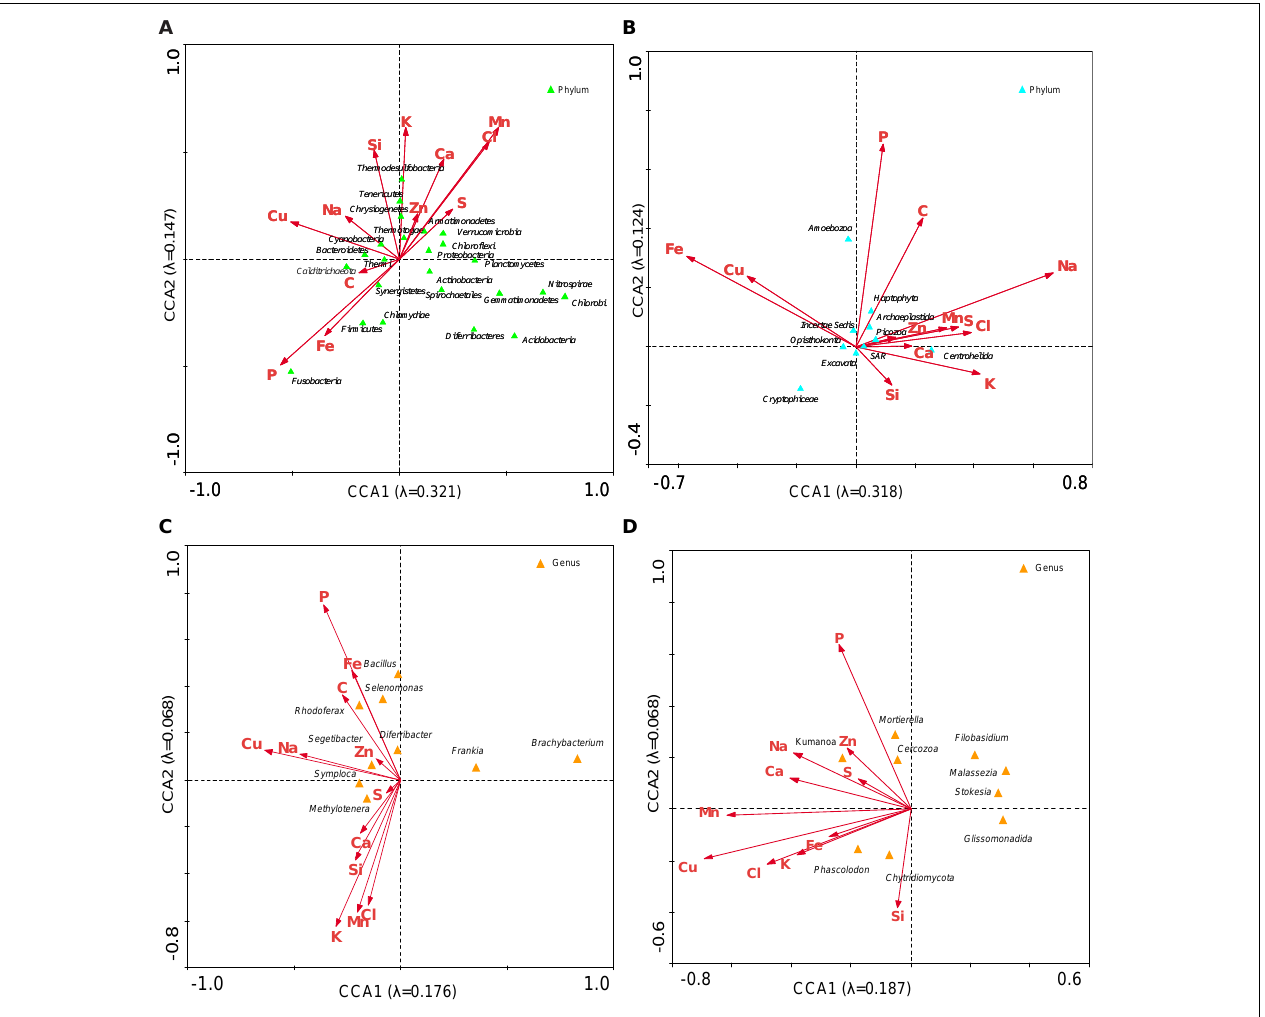
FIGURE 5 | CCA of the microbial groups with respect to the concentration of ions. Analysis of (A) bacterial phyla, (B) eukaryotic phyla, (C) bacterial genera, and (D) eukaryotic genera with respect to concentration of C, Na, Si, P, S, Cl, K, Ca, Mn, Fe, Cu, and Zn. Correlations between microbial community and ions are represented in